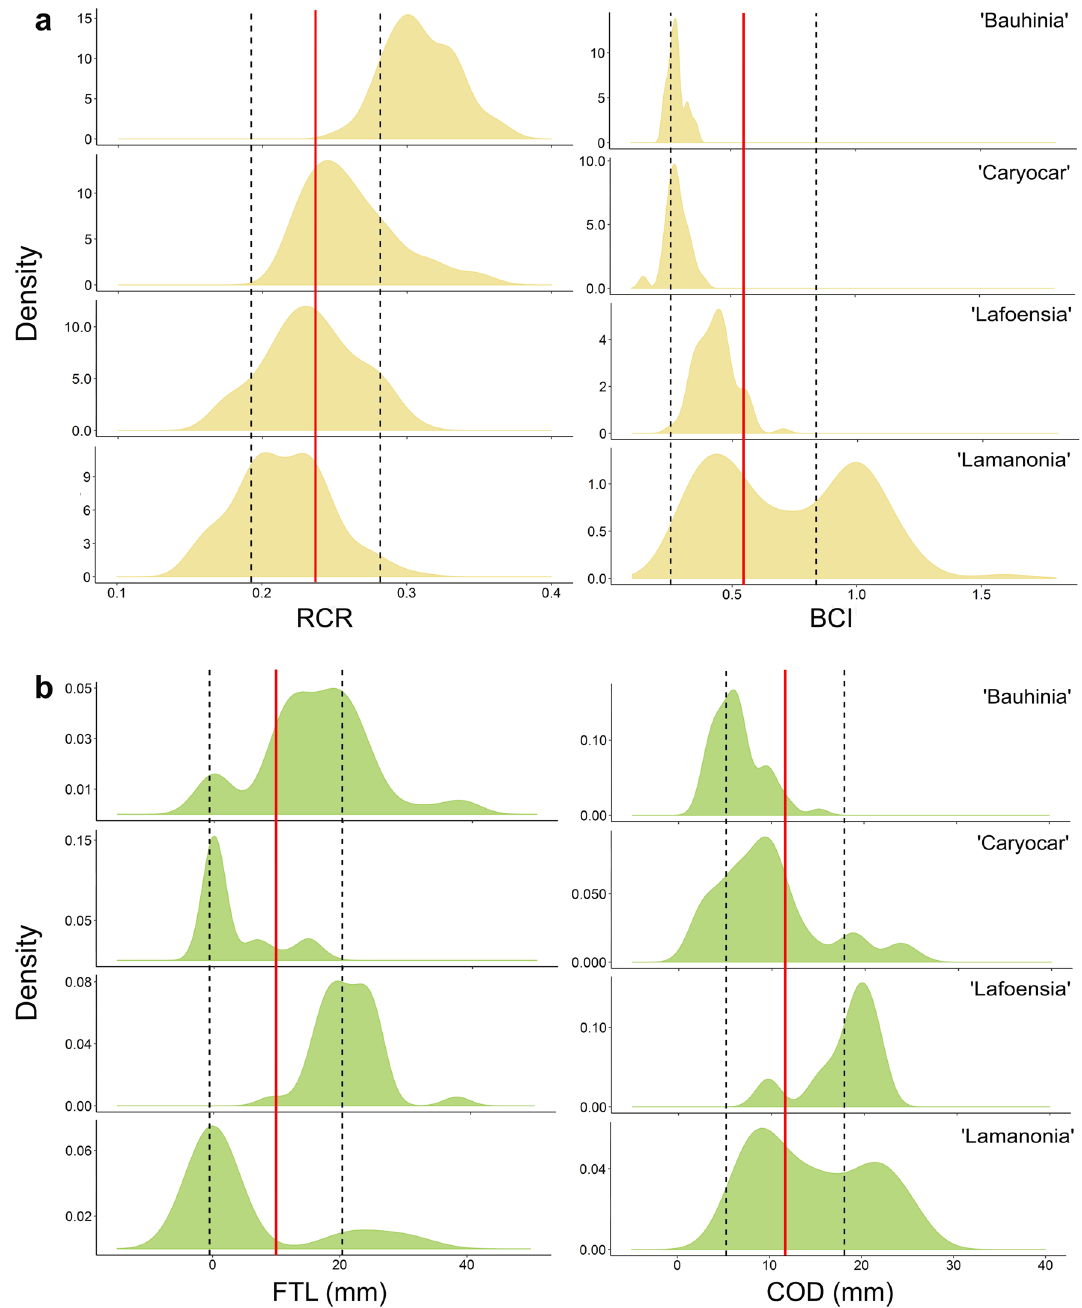
Figure 3. Density distribution of morphological variables from species in the network across modules. ( a ) Bats (RCR—rostrum-cranium ratio, and BCI—body condition index); ( b ) plants (FTL—floral tube length, and COD corolla outermost diameter). Module names correspond to those in Fig. 1. Solid red lines show the mean of each variable for all species pooled, and dashed lines indicate the standard